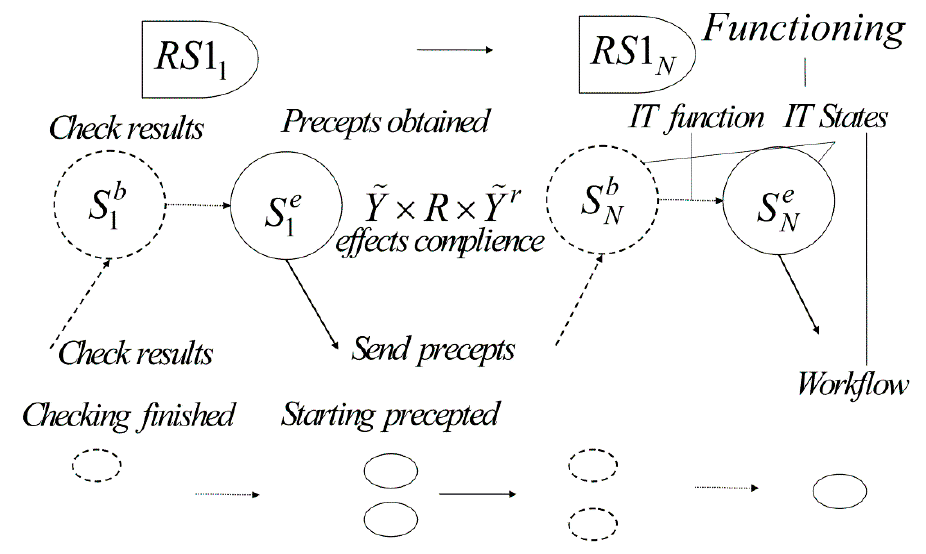
Figure 5. Role of information operations during system functioning effects formation. RS: reduced simplex.